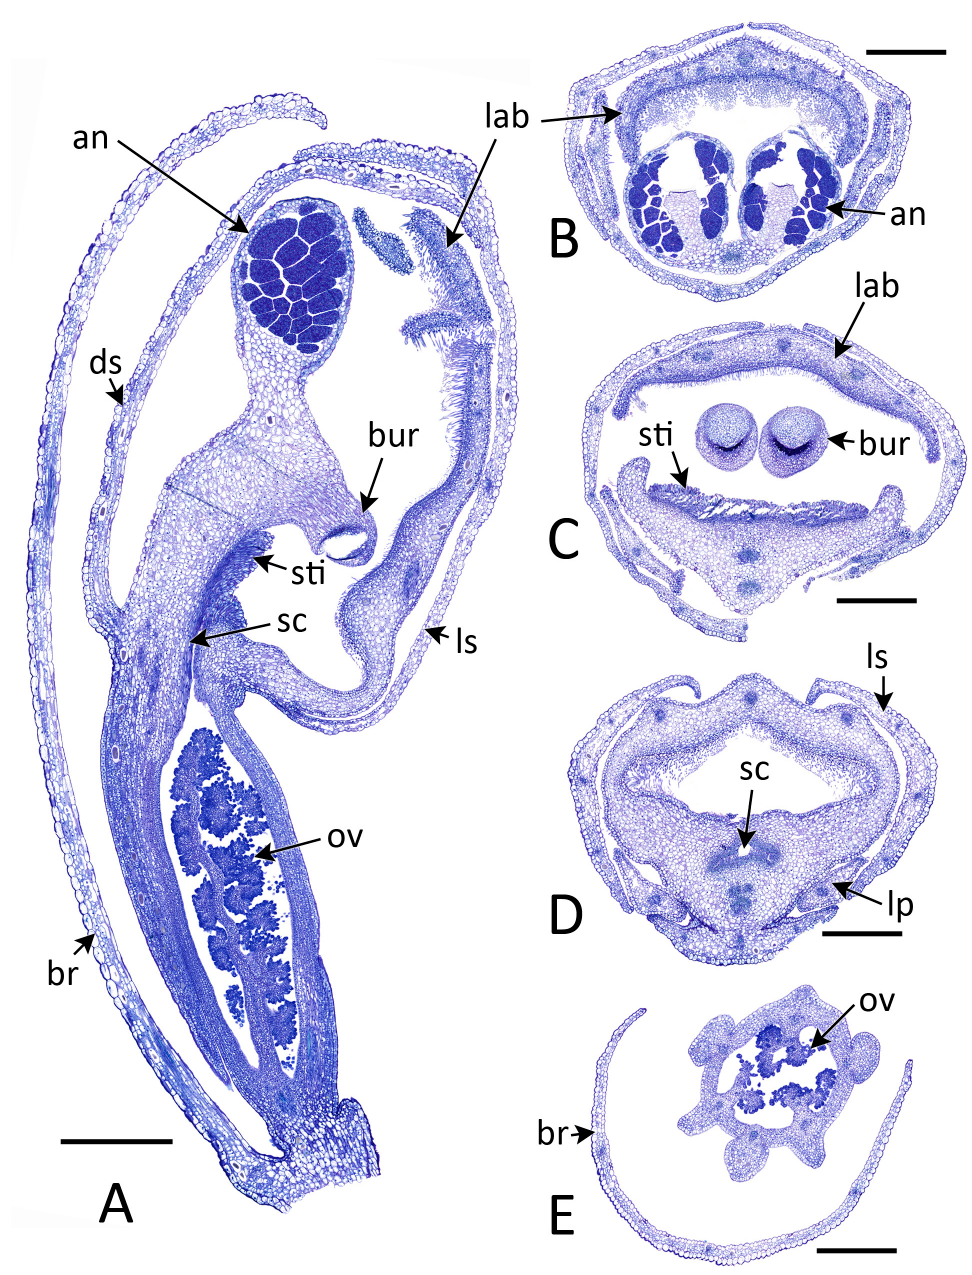
Figure 3. Anatomical sections of pre-anthetic flower bud of O. pallida (mesospecies Obaesa , macrospecies Fusca). ( A ) Median longitudinal section, showing entire bud subtended by bract. The anther, stigma and prominent bursicles are enclosed on one side by the labellum (which become strongly recurved once the flower has opened); it bears localised projecting trichomes. Note the exceptionally narrow stylar canal below the stigmatic papillae—a constriction encouraging pollen-tube competition. The elongate ovary contains numerous tiny ovules borne on branched placentae. Nectaries are absent. ( B – E ) Transverse sections. ( B ) Distal region, showing the anther, which contains dark-staining massulae, and the labellum, which bears outward- and backward-projecting trichomes. ( C ) Central region, showing the stigma and the lower parts of the prominent bursicles. ( D ) Proximal region, showing the narrow stylar canal. ( E ) Unilocular ovary containing many tiny ovules borne on branched parietal placentae. Labels: an, anther; bur, bursicle; br, bract; lab, labellum; lp: lateral petal; ls, lateral sepal; ov, ovules; sc, stylar canal; sti, stigma. All scales = 1 mm. All images: Paula Rudall.